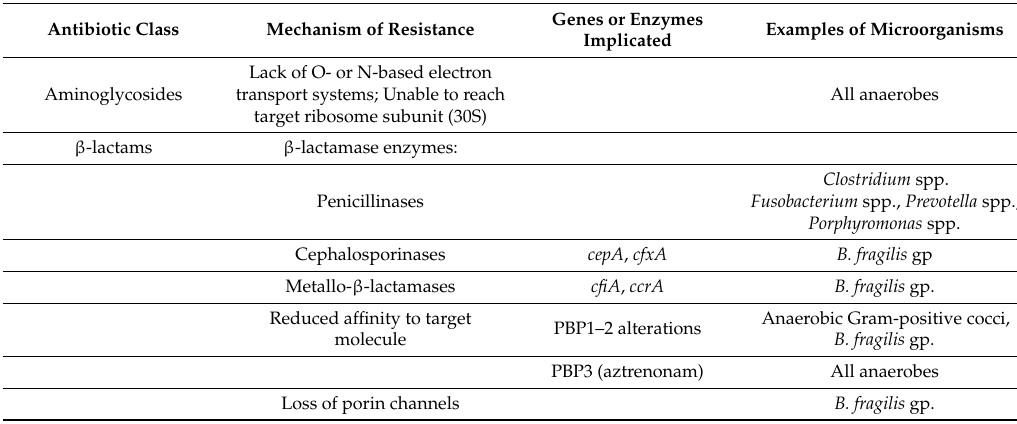
Table 8. Examples for antimicrobial resistance mechanisms exhibited by anaerobes